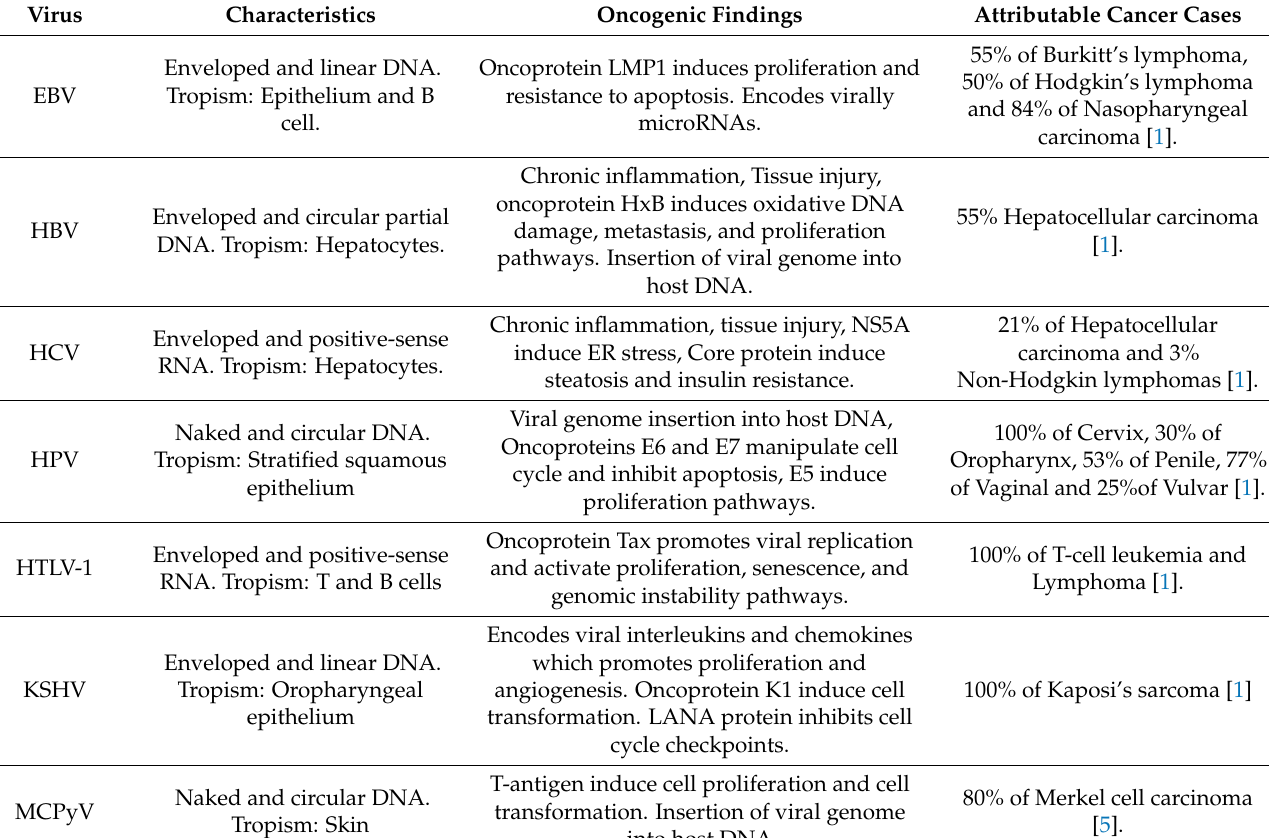
Table 1. Human oncoviruses-associated cancer